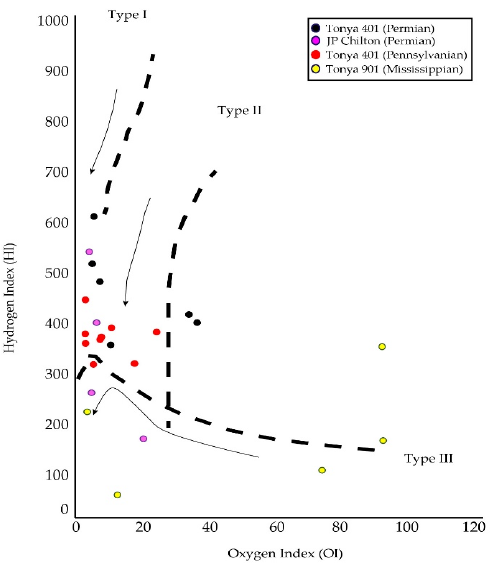
Figure 11. Organic matter types with arrows indicating the progression of maturation modified from Taylor et al., 1998 [120].